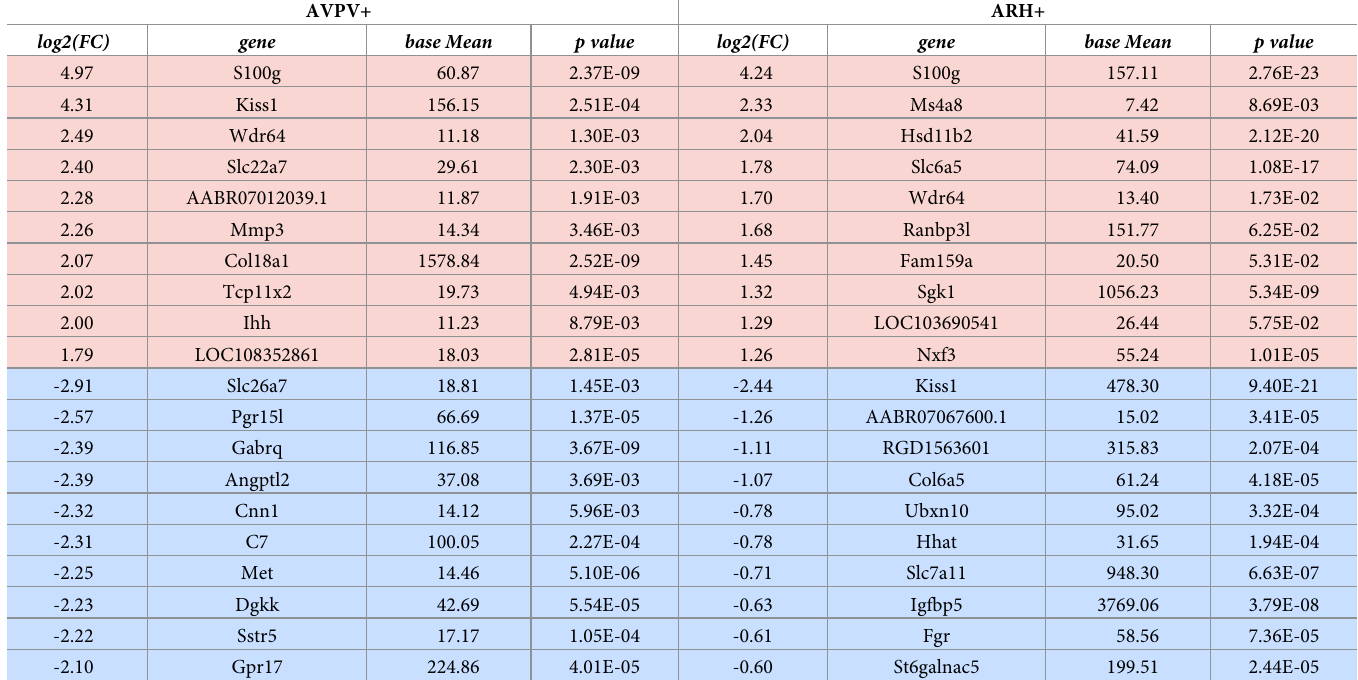
Table 3. Top DE genes baseline vs 24 hrs post-